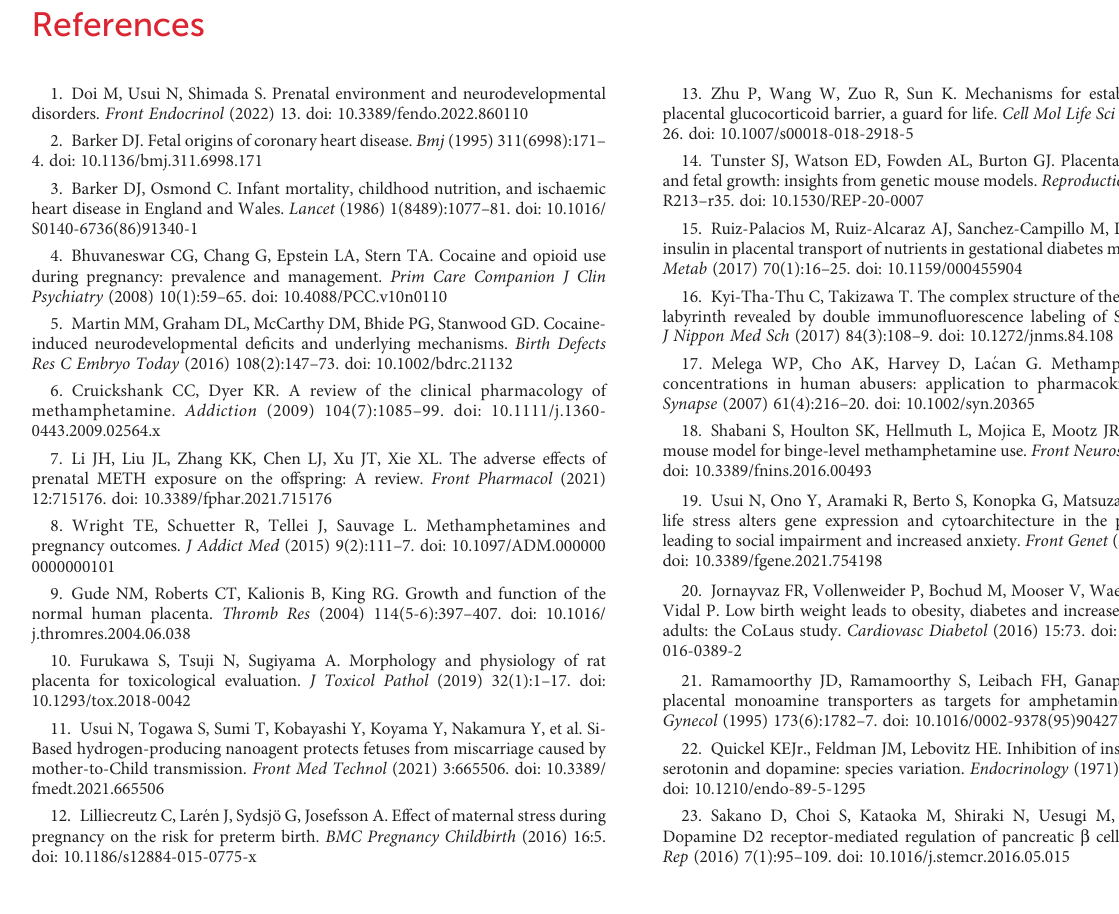
SUPPLEMENTARY FIGURE 1 Glycogen synthase 1 (GYS1) expression was reduced in METH-exposed placenta. Representative images of GYS1 positive (+) regions in the placentas at E18.5 and its quanti fi cation in the placentas. The expression levels of GYS1 in the placenta was signi fi cantly reduced in METH-exposed placenta. Dataarepresentedasmeans(±SEM). * P <0.05,unpaired t -test, n =